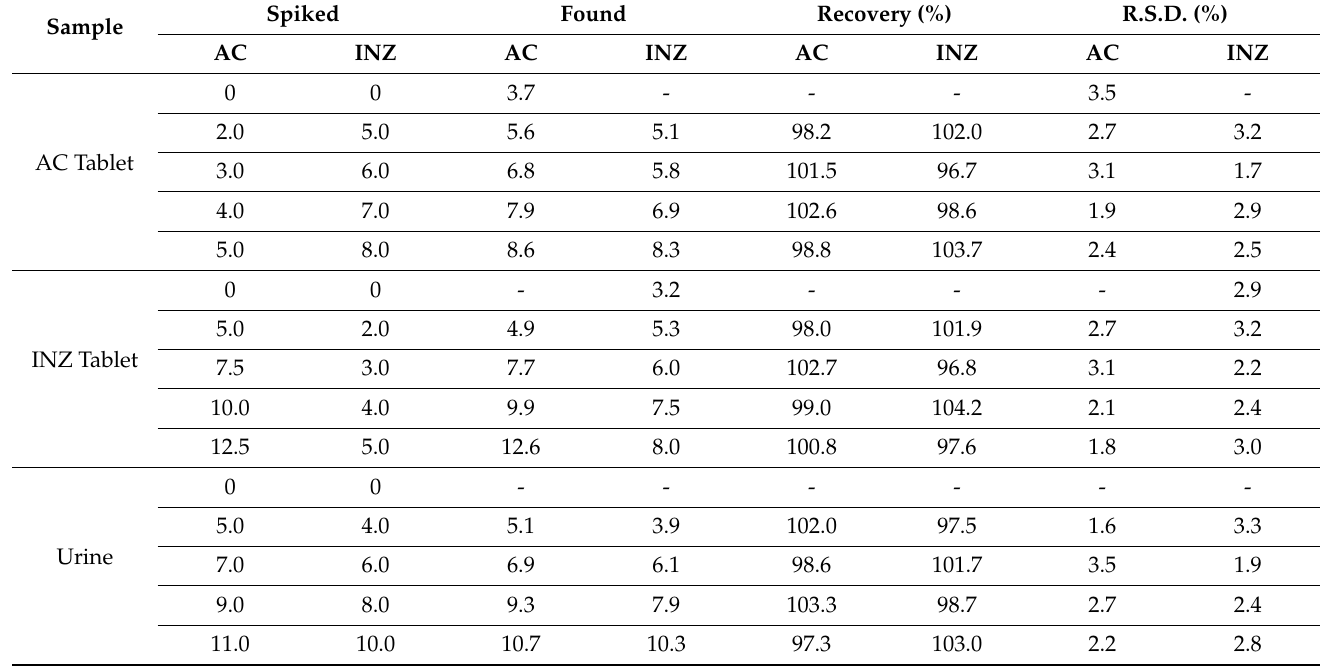
Table 2. Determining AC and INZ in real specimens on MoS 2 NSs-SPE. All concentrations are in µ M ( n =